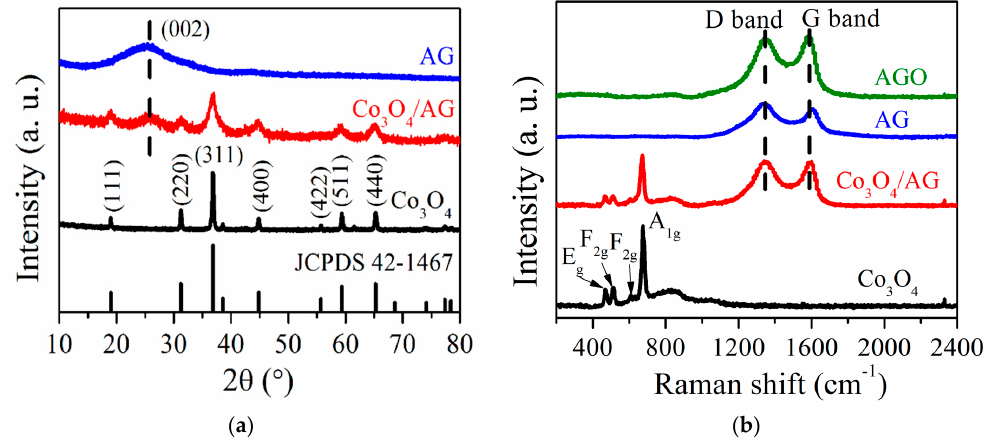
Figure 2. XRD patterns ( a ) and Raman spectra ( b ) of Co 3 O 4 , AG, and the Co 3 O 4 / AG